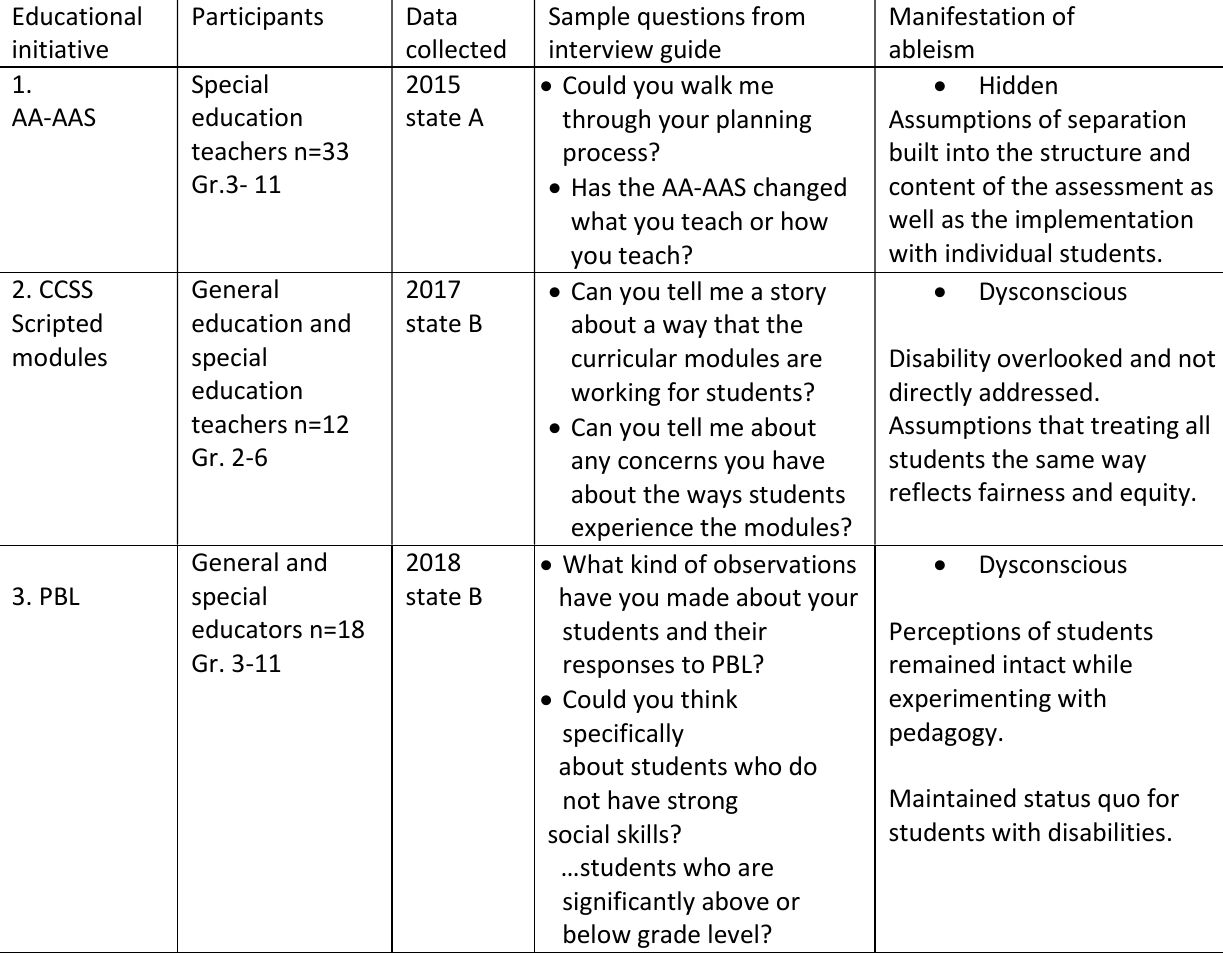
Sample questions from Manifestation of interview guide